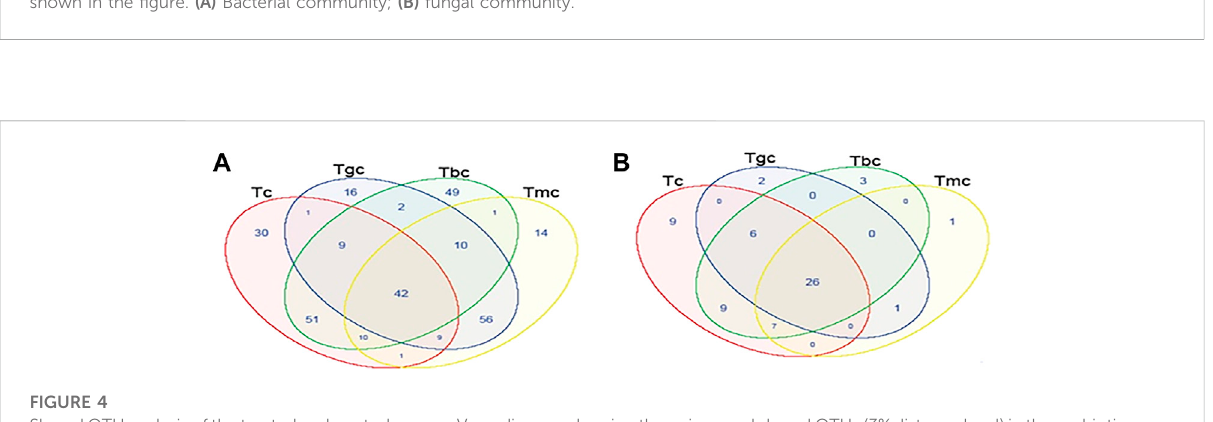
FIGURE 3 (A , B) Distribution of bacterial and fungal genera among treated and control groups. Double hierarchically clustered heatmap showing the bacterialand fungaldistributionamongthecomposition.Theheatmapdepicts theOTUcountsofeachbacterialandfungal genus(clusteringonthe Y -axis)within eachsample (clustering on X -axis).Relative values forbacterialandfungalgeneraare depictedbythecolorintensity withthecolorkey shown in the fi gure. (A) Bacterial community; (B) fungal community.